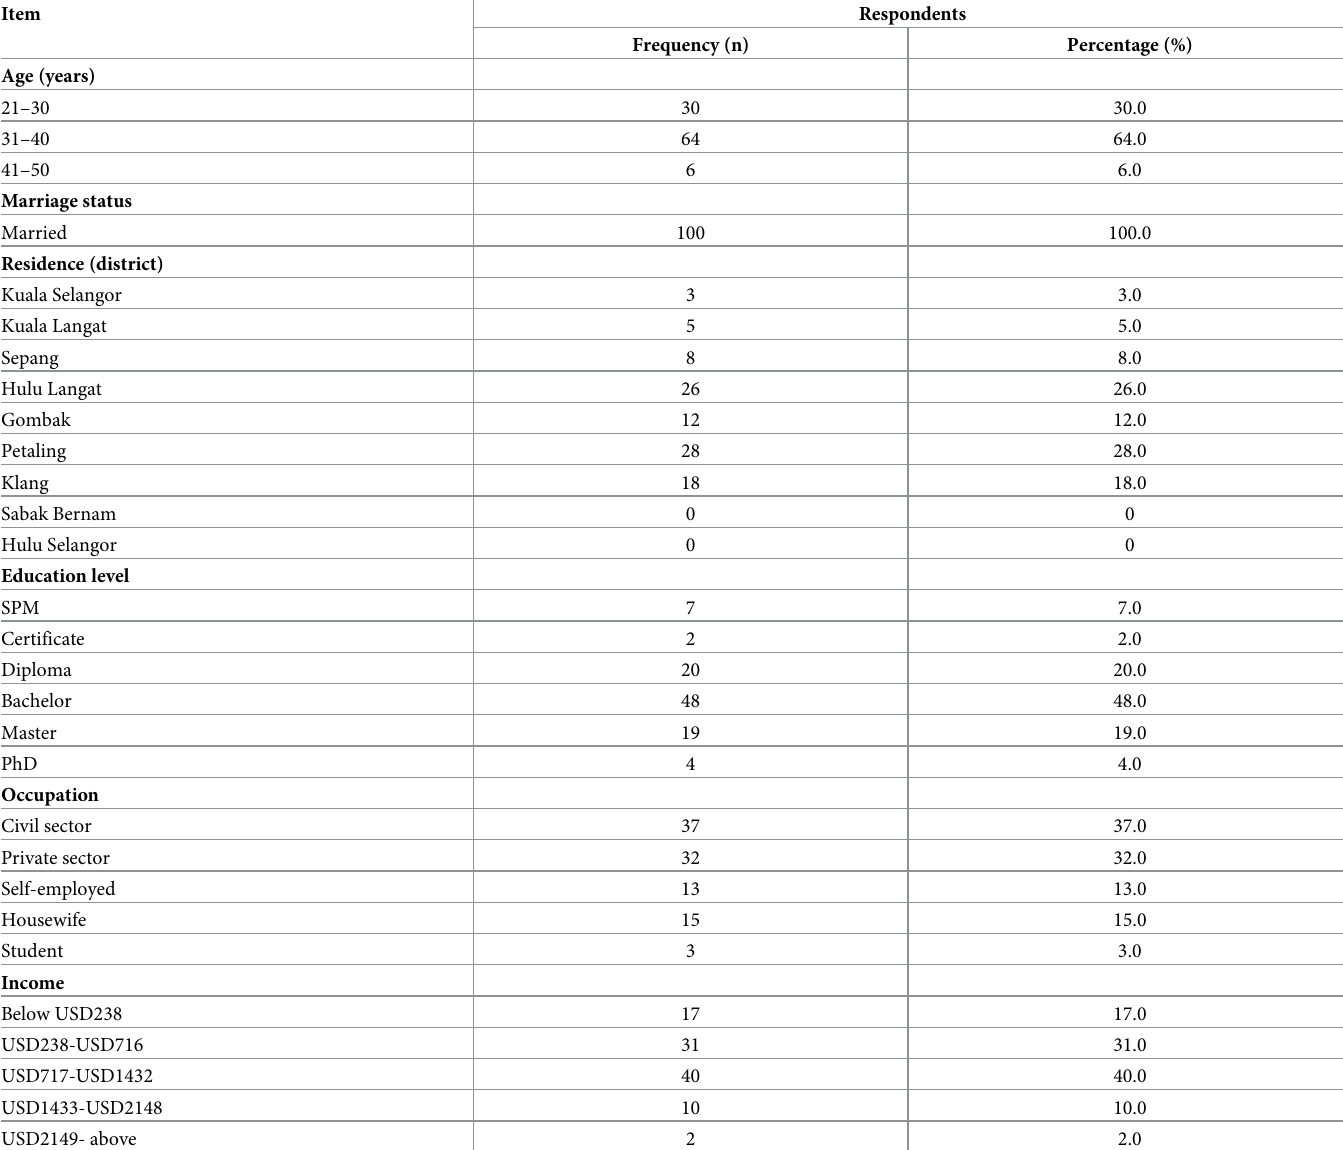
Table 1. Sociodemographic characteristics of